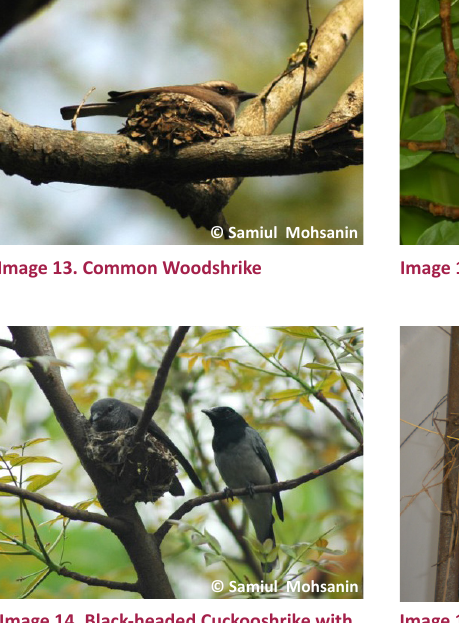
Image 17. Common Myna nest in electrical box